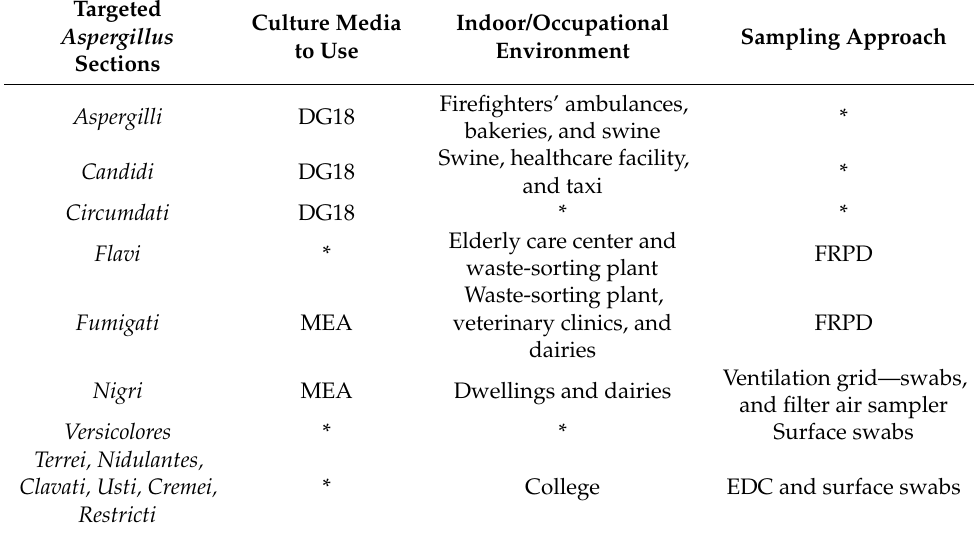
Table 3. Information to be considered in a sampling strategy targeting specific Aspergillus